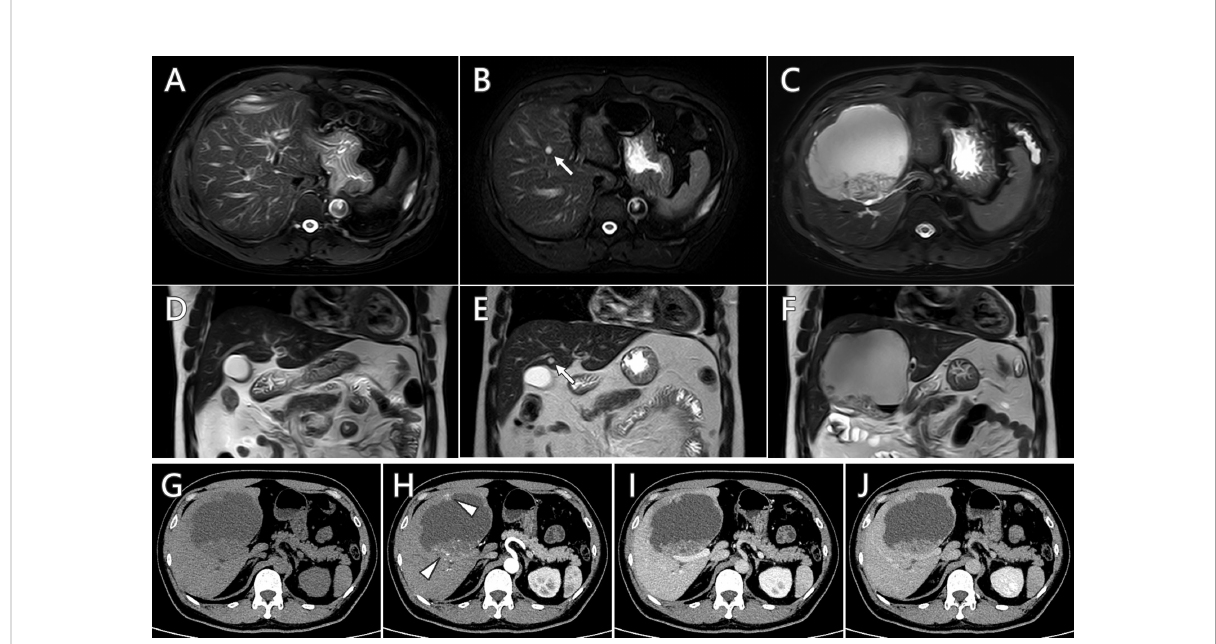
FIGURE 1 Serial follow-up MR imaging (A – F) and contrast-enhanced CT scan (G – J) of the hepatic cystic lesion. The newly detected lesion (C, F) did not exist 12 months ago (A, D) and emerged as a small cystic lesion 7 months ago ( B, E , arrow). Mild enhancement at the solid parts (arrowhead) was observed in contrast-enhanced CT